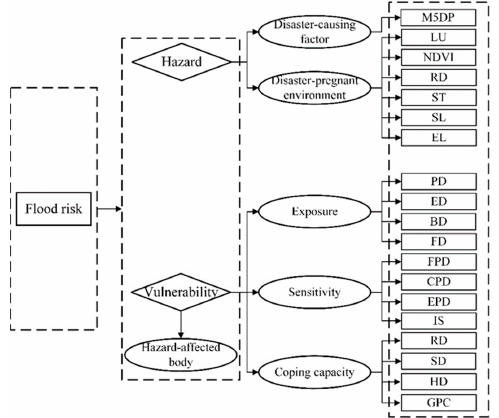
Figure 1. The index system of global flood risk. Note: M5DP, maximum 5-day precipitation; LU, land use; RD, road density; ST, soil texture; SL, slope; EL, elevation; PD, population density; ED, economic density; BD, building density; FD, farmland density; FPD, female population density; CPD, child population density; EPD, elderly population density; IS, impervious surface; RD, road density; SD, shelter density; HD, hospital density; GPC, GDP per capita.